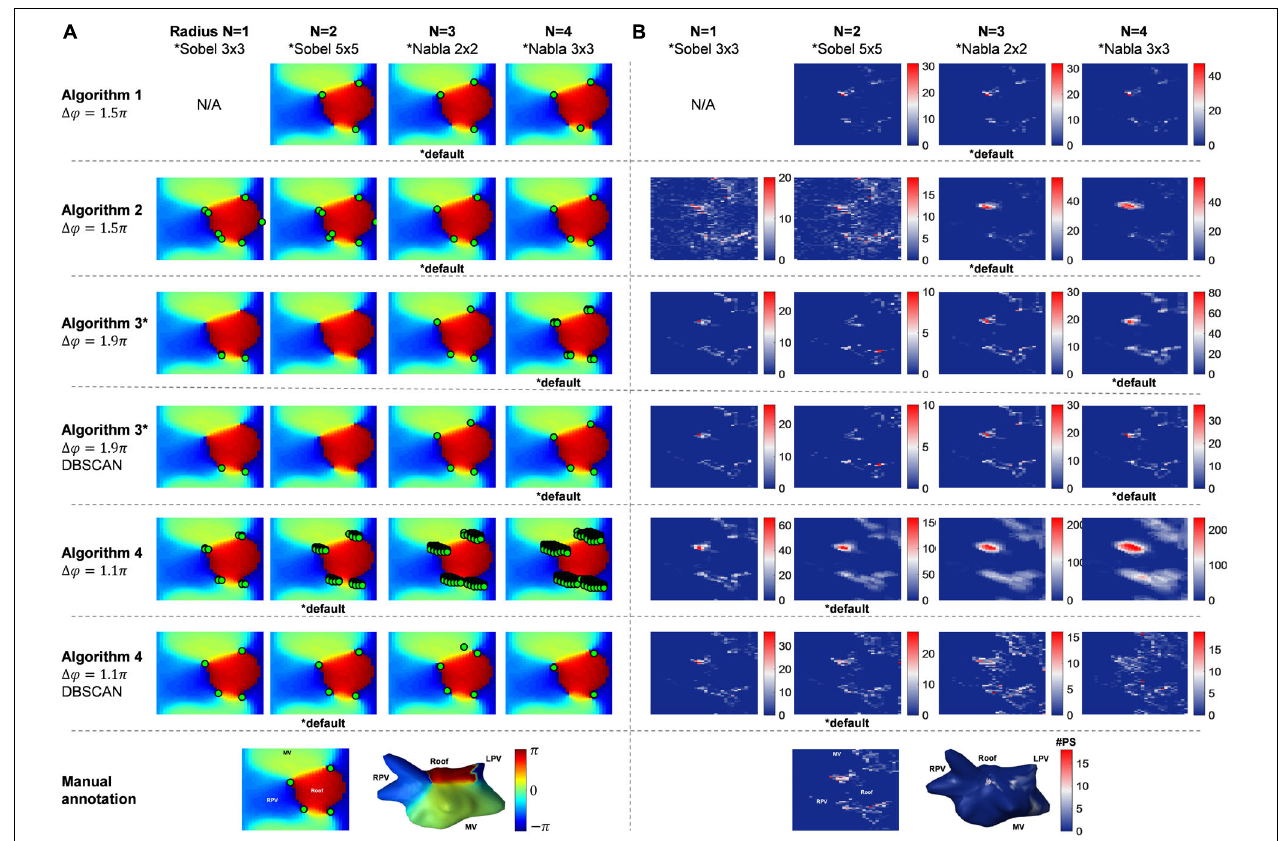
FIGURE 6 | The effect of different choice of search radius (kernels in Algorithm 3). (A) An example of the performance of the Algorithms 1–4 and Algorithm 3 and 4 with DBSCAN different search radius parameter, the bottom row is the 3D and 2D phase map with manual annotation. (B) PSD maps of the example VEGMs (476.5 ms) using algorithms with different search radius parameter, the bottom row is the 3D and 2D PSD maps with manual annotation.